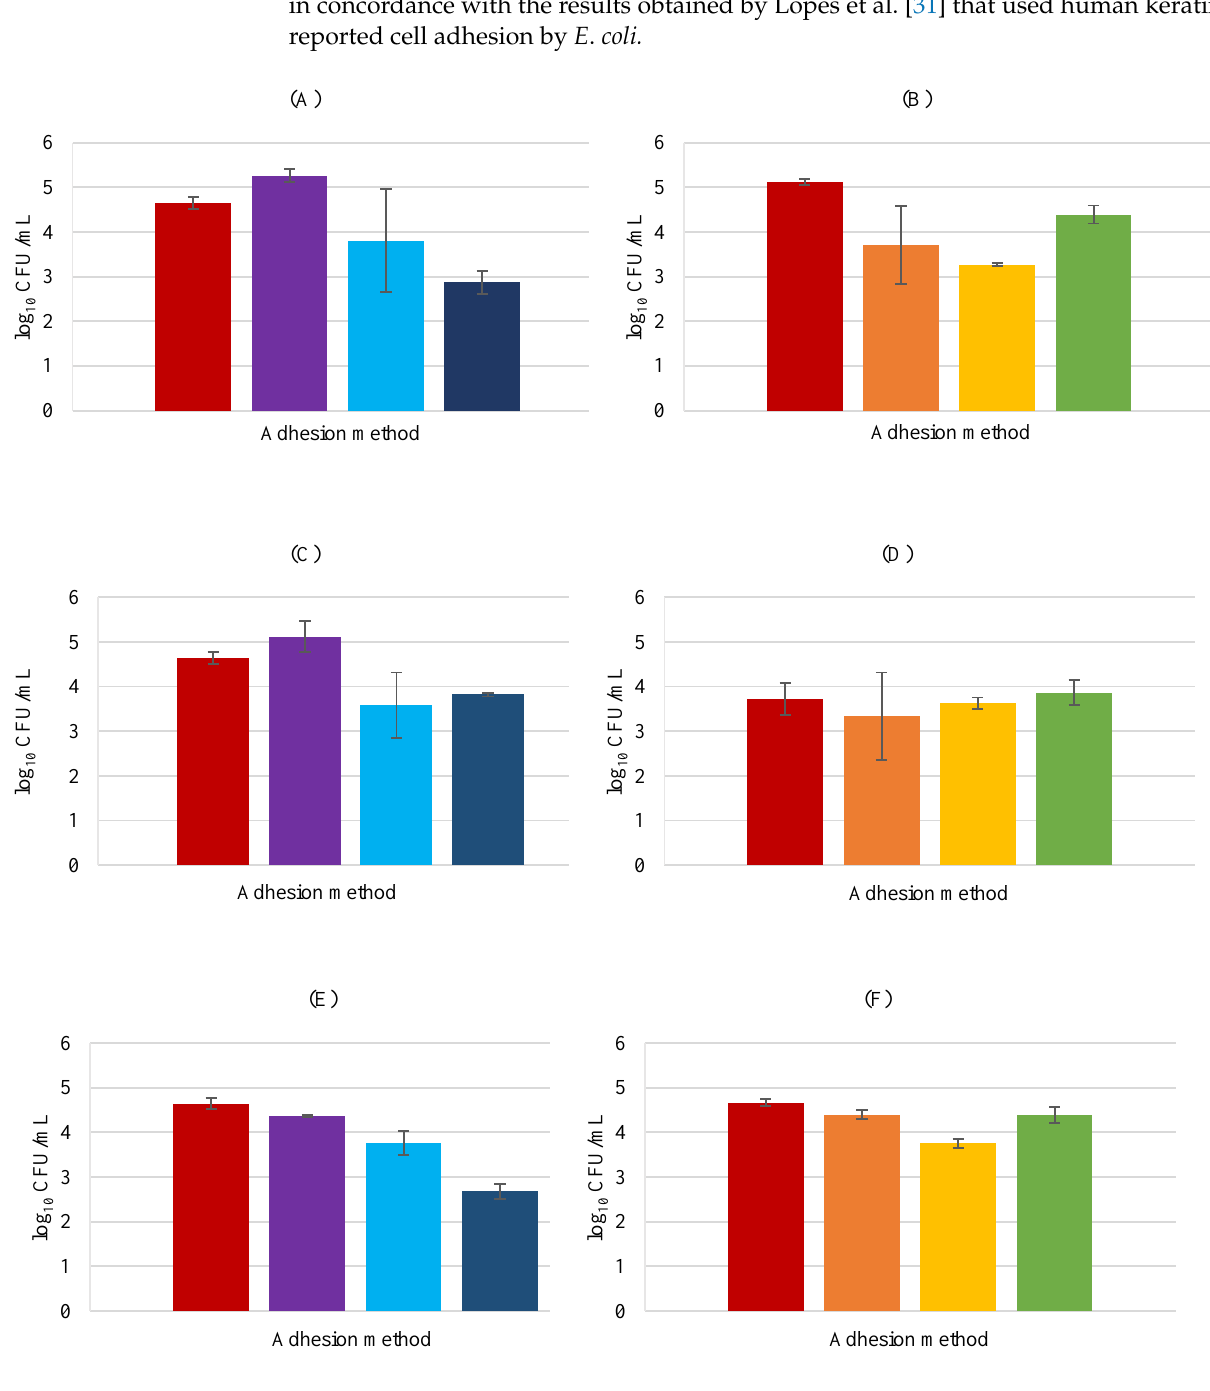
Figure 5. HaCaT cell adhesion by E . coli in the presence of probiotics. E . coli plus L . rhamnosus ( A , B ) E . coli plus L . delbrueckii ( C , D ) E . coli plus P. innocua ( E , F ). In BHI medium counts ( A , C , E ) exclusion ( (cid:4) ), displacement ( (cid:4) ), and competition ( (cid:4) ); MRS medium counts ( B , D , F ) exclusion ( (cid:4) ), displacement ( (cid:4) ), and competition ( (cid:4) ); and respective control ( (cid:4) ). Error bars are ± standard